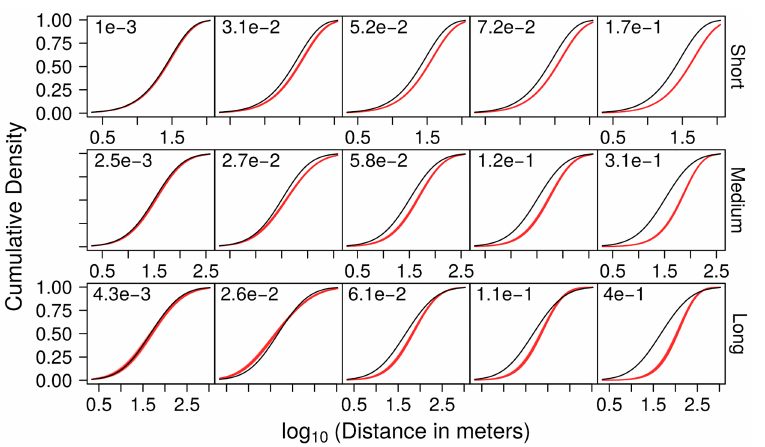
Fig 4. Comparison of simulated and estimated dispersal kernels. From left to right: kernels with the minimum, lower quartile, median, upper quartile and maximum Kullback-Leibler (KL) distances (posterior mean), as estimated (red) under the most exhaustive scheme ( Θ 4 ), based on simulated epidemics with short-, medium- and long-range kernels (from top to bottom; black). Kernels are represented by their marginal cumulative distribution function F 1 D (with distance from the source represented on the log 10 scale). The mean KL distance is indicated for each estimation.